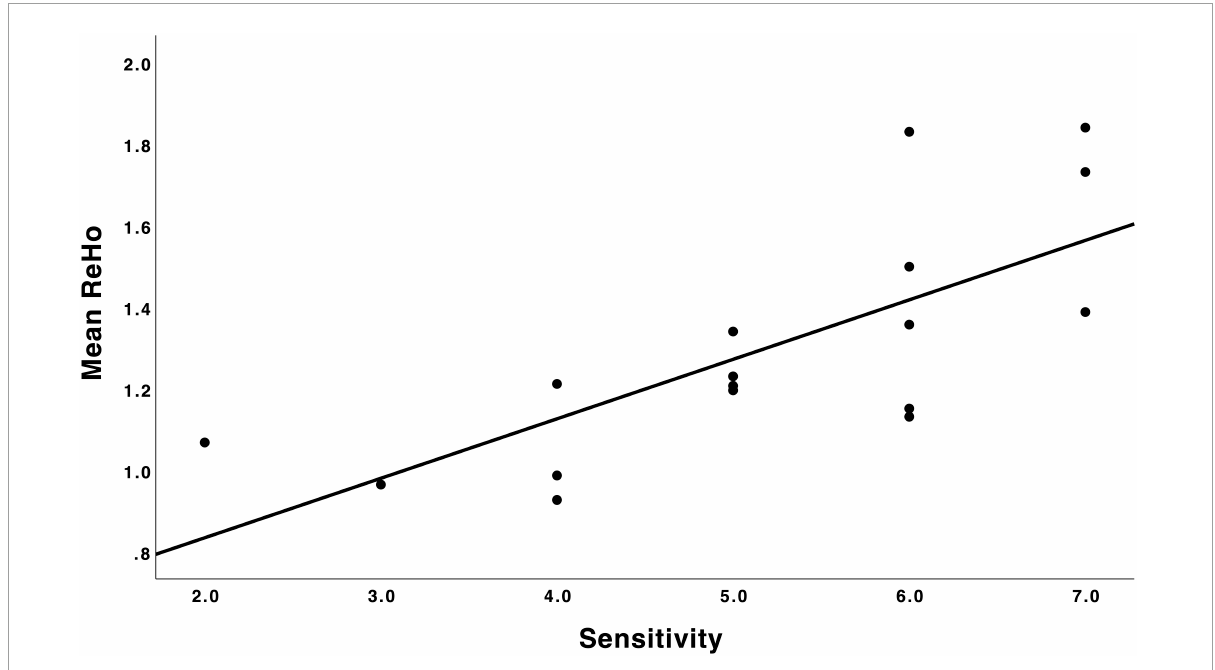
FIGURE2 Scatter plot depicting the relation between maternal sensitivity during infancy ( N = 17) and mean ReHo in the mPFC. A higher maternal sensitivity score was associated with higher regional homogeneity in the mPFC. ReHo, regional homogeneity; mPFC, medial prefrontal